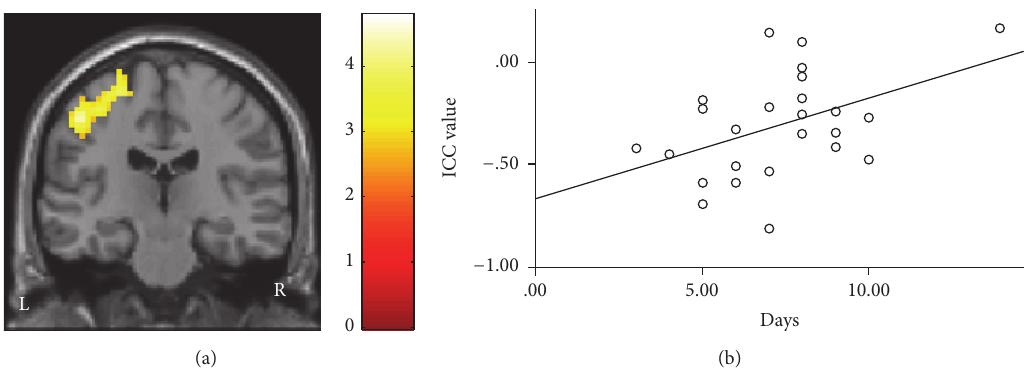
Figure 2: Intrinsic connectivity contrast (ICC) results. (a) ICC value was decreased in the contralateral S1/M1 in Bell’s palsy patients. (b) There was a positive association between the duration of a subject’s BP and the ICC value ( 𝑝 < 0.035